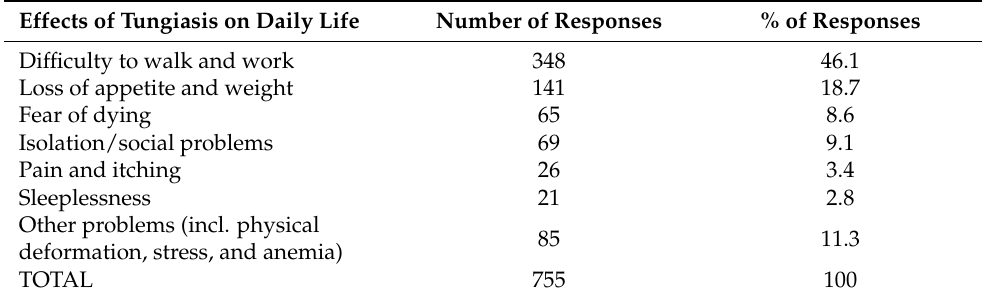
Table 2. Effects of tungiasis on everyday life (open-text question). Several individuals gave more than one response; therefore, the number of responses ( n = 755) was higher than the number of respondents ( n =